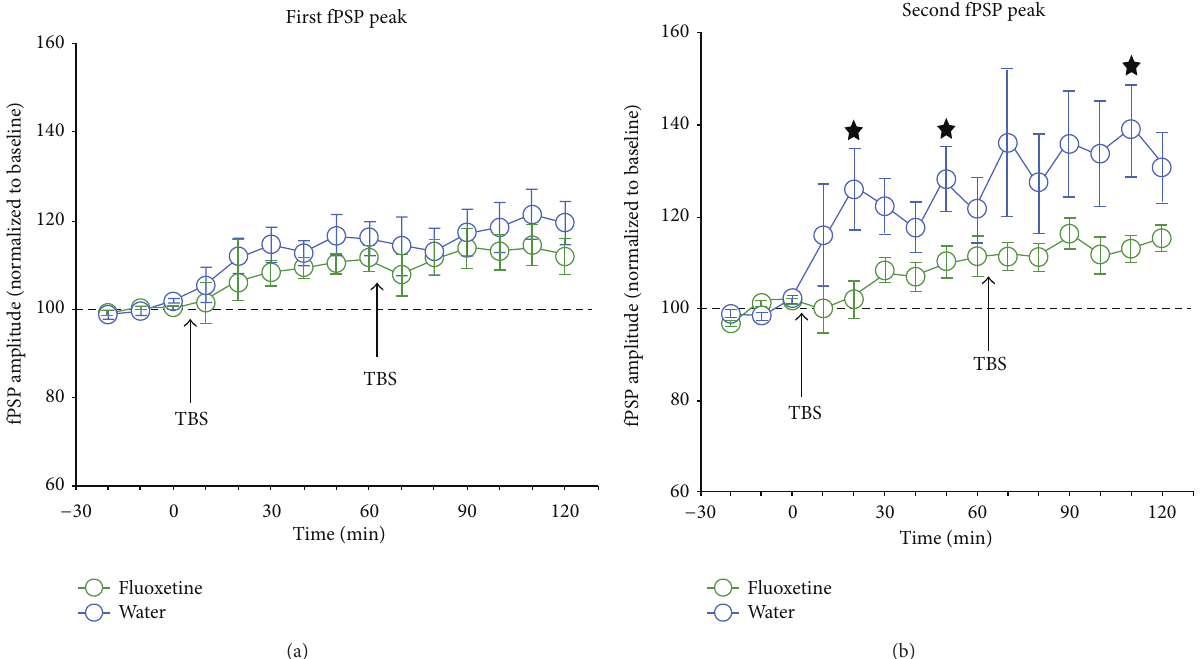
Figure 3: Amplitude of the first (a) and second (b) peak of field postsynaptic potentials (fPSPs) in the auditory cortex of rats treated with water ( 𝑛 = 11 ) or fluoxetine ( 𝑛 = 14 ), and the effect of theta-burst stimulation (TBS, at arrow) of the medial geniculate nucleus. Two episodes of TBS resulted in significant increases of amplitude of both the first (a) and second (b) fPSP peak in both groups of rats. However, for the second fPSP peak, fluoxetine-treated rats showed significantly less LTP than that seen in water animals. ANOVA results for (a) effect of time, 𝐹(14,322) = 10.4 , 𝑃 < 0.0001 ; effect of group, 𝐹(1,23) = 0.8 , 𝑃 = 0.4 ; interaction, 𝐹(14, 322) = 0.5 , 𝑃 = 0.9 . ANOVA results for (b) effect of time, 𝐹(14,252) = 10.0 , 𝑃 < 0.0001 ; effect of group, 𝐹(1,18) = 3.6 , 𝑃 = 0.08 ; interaction, 𝐹(14,252) = 2.2 , 𝑃 = 0.007 ; ∗ indicates significant ( 𝑃 < 0.05 ) simple effects tests comparing the two treatment groups. (Note that group sizes for the analysis of the second peak were 𝑛 = 9 and 𝑛 = 11 for water and fluoxetine rats, resp., since this peak could not be consistently resolved in all